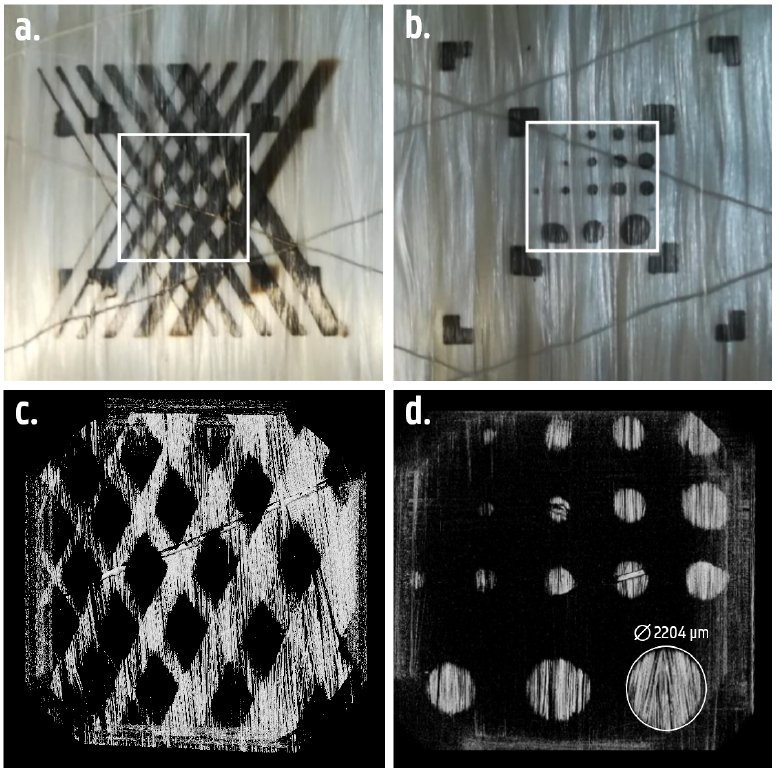
Figure 9. ( a , b ) show a 300 nm thin film pattern of tantalum deposited on dry glass fibers. The ad- herence of the films on the fibers was good, and the patterns remained geometrically stable along the resin infusion and curing process. ( c , d ) show their respective reconstructed patterns from the computed tomography-scans after the patterned fibers are integrated in a 1.2 cm thick composite plate. Figures adapted from